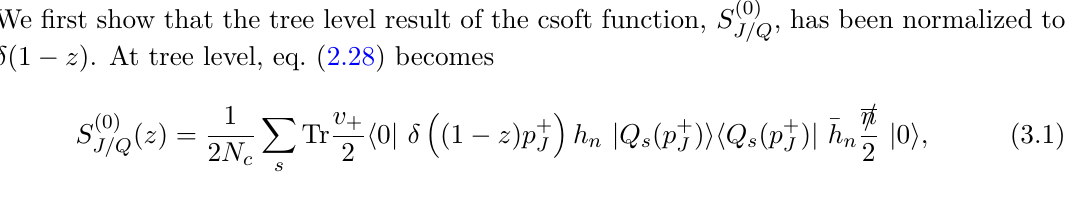
Figure 2 . Feynman diagrams for the one-loop calculation of the csoft function S denote the bHQET field h n , and k is a csoft momentum. Virtual diagram (a) and real radiation diagram (b) have hermitian conjugate mirror